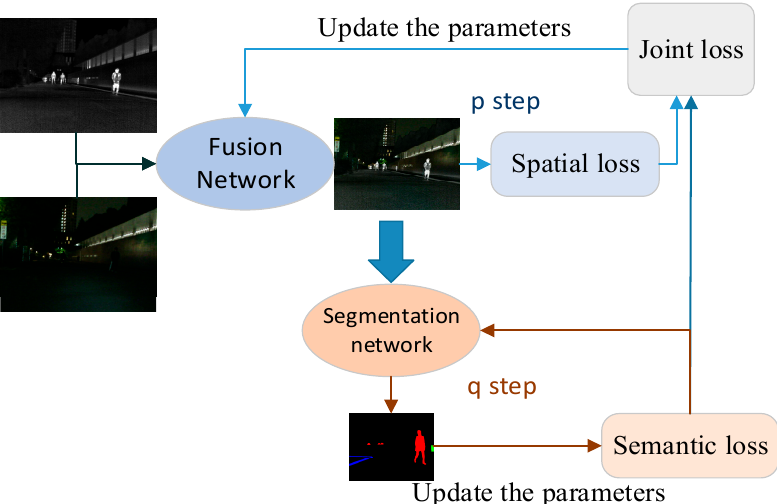
Figure 2. The SeAFusion algorithm training process.